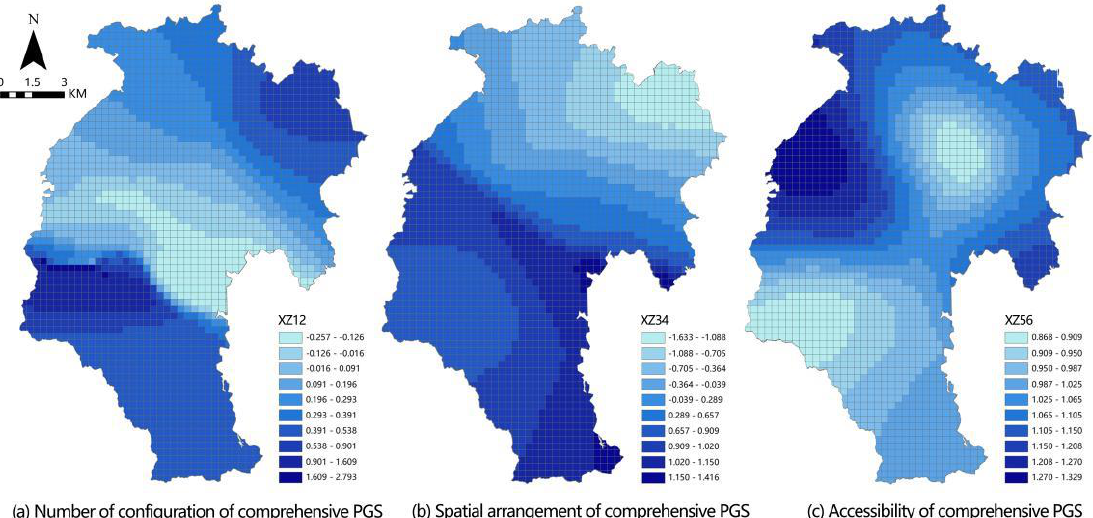
Figure 11. Spatial patterns of correlation coefficients between subsystems of comprehensive PGS and CCD.